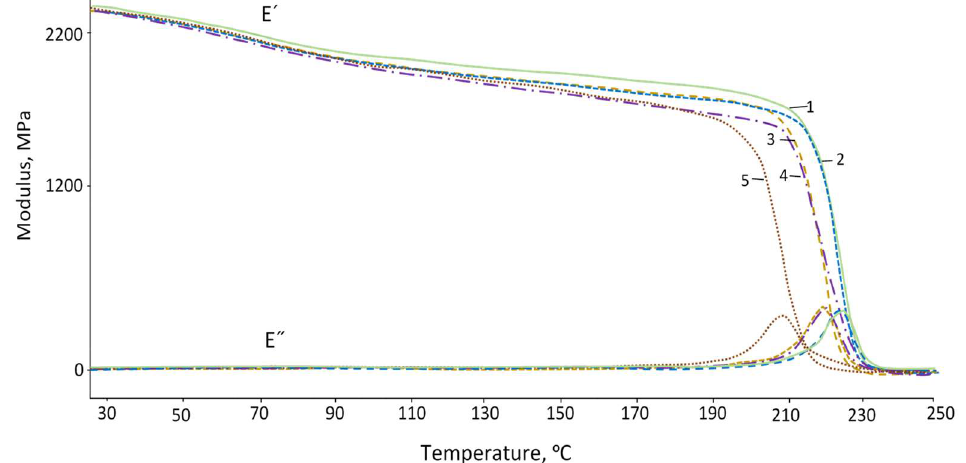
Figure 2. Storage modules (E′) and loss modules (Е″) of PPSU blends: 1—PPSU-17; 2—PPSU-6/38; 3—PPSU-2/54; 4—PPSU-3/292; 5—PPSU-3/n/f.